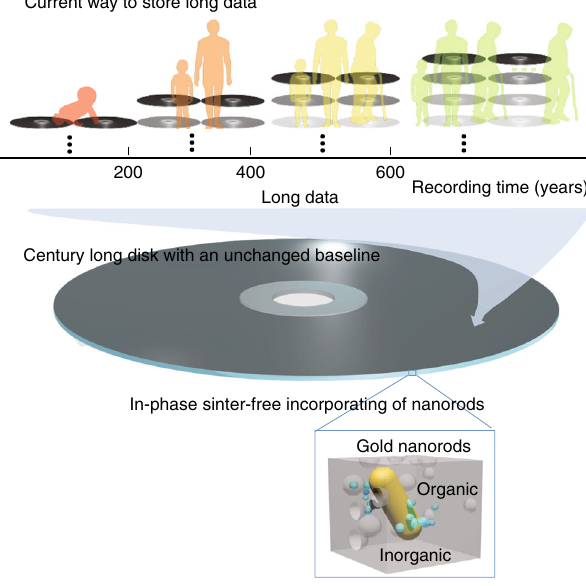
Fig. 1 Century-long optical data memory with an unchanged baseline with nanoplasmonic hybrid glass composites. Transformation from the current way to store long data with the variation of baselines into the century-long optical data memory with an unchanged baseline in nanoplasmonic hybrid glass composites. The gray-scale in the disks indicates the change of the baseline over time. Inset: Schematic drawing of the nanoplasmonic hybrid glass